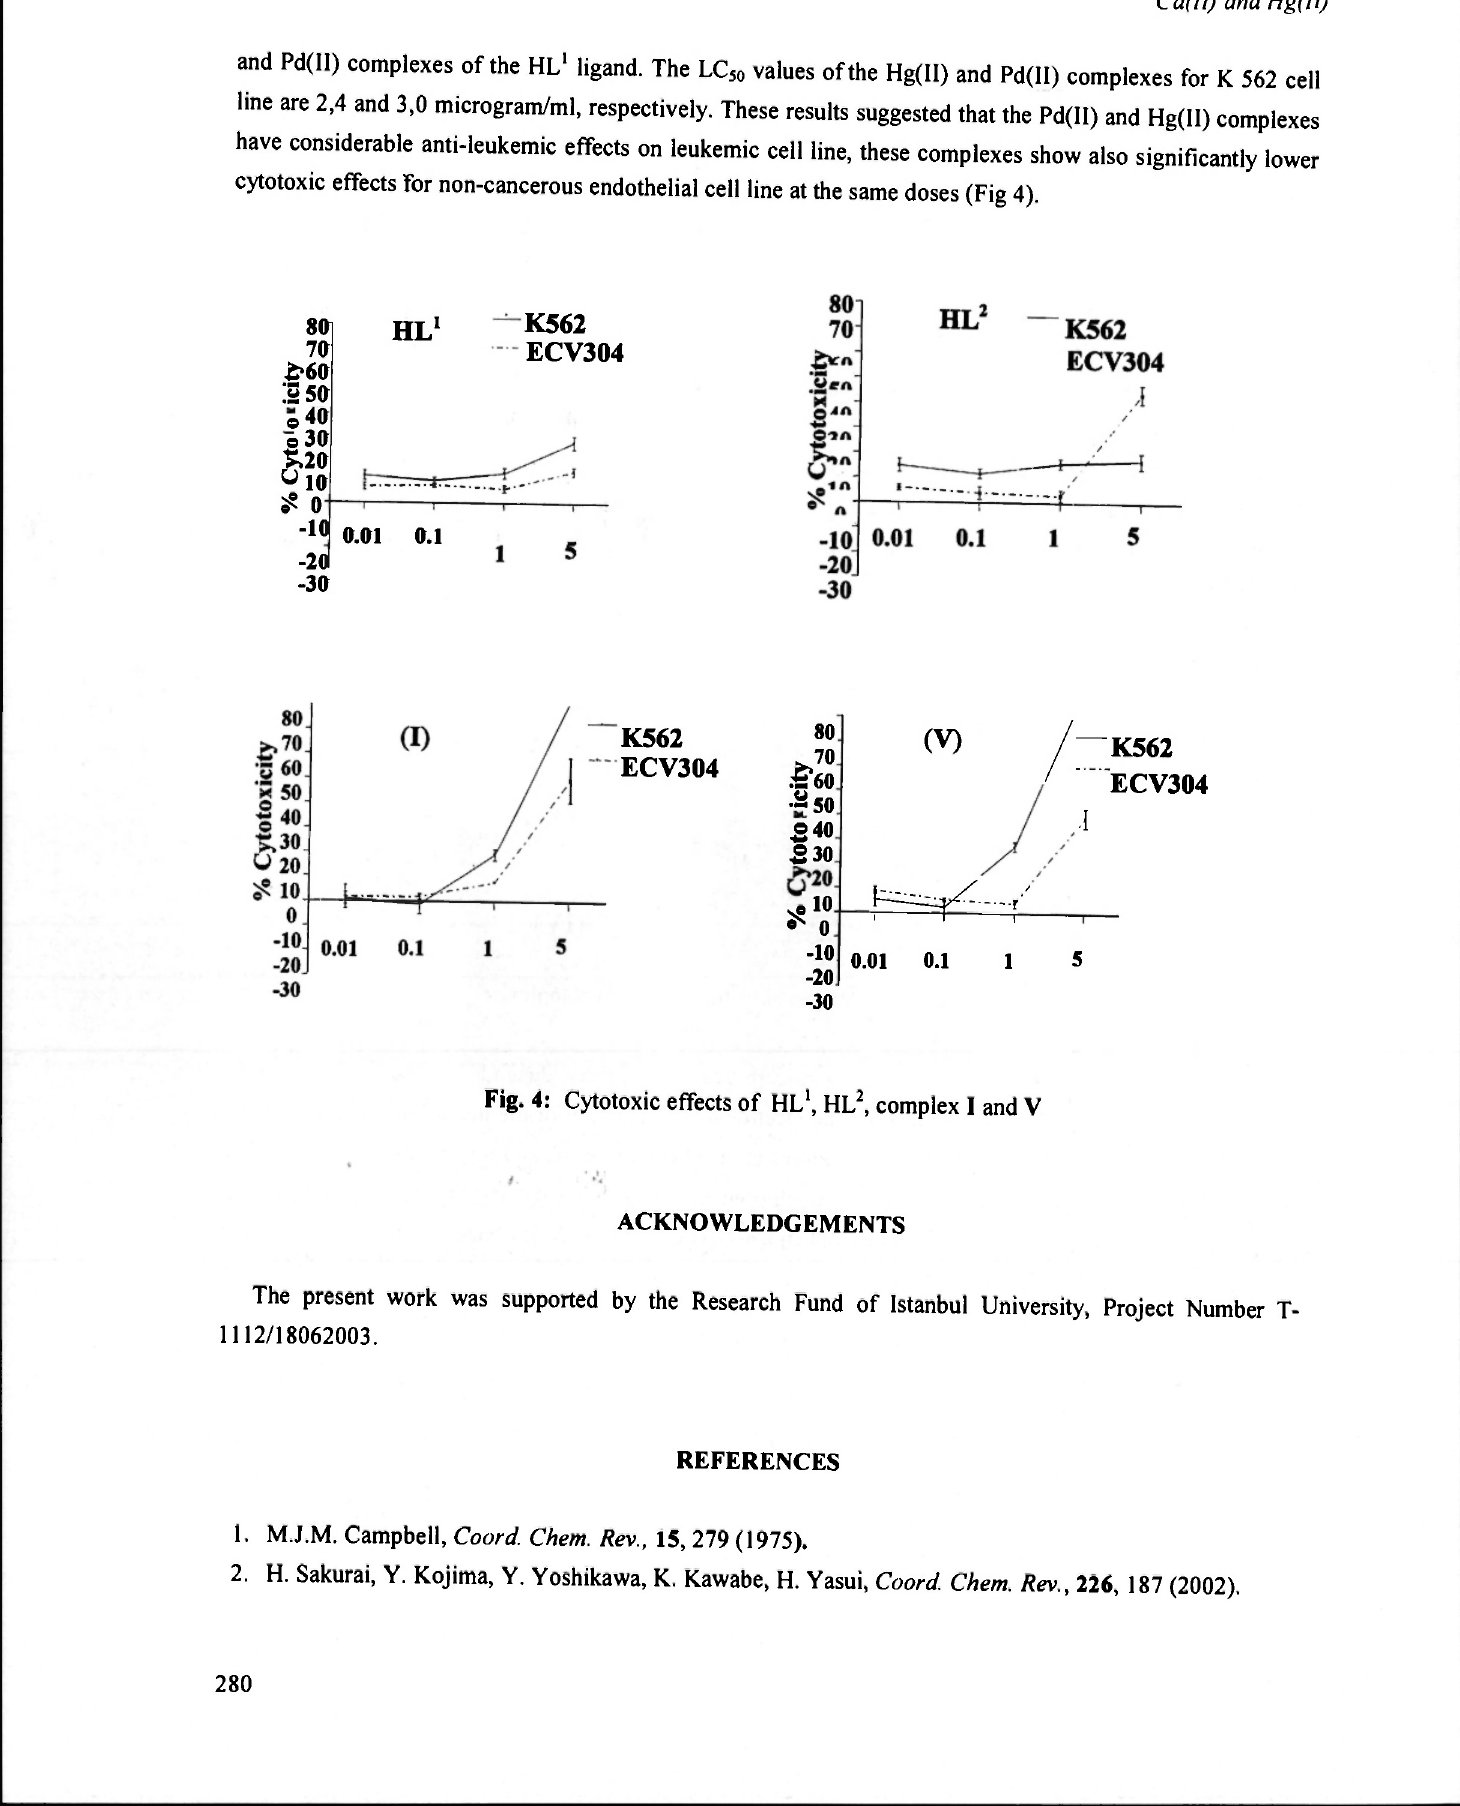
Fig. 4: Cytotoxic effects of HL 1 , HL 2 , complex I and